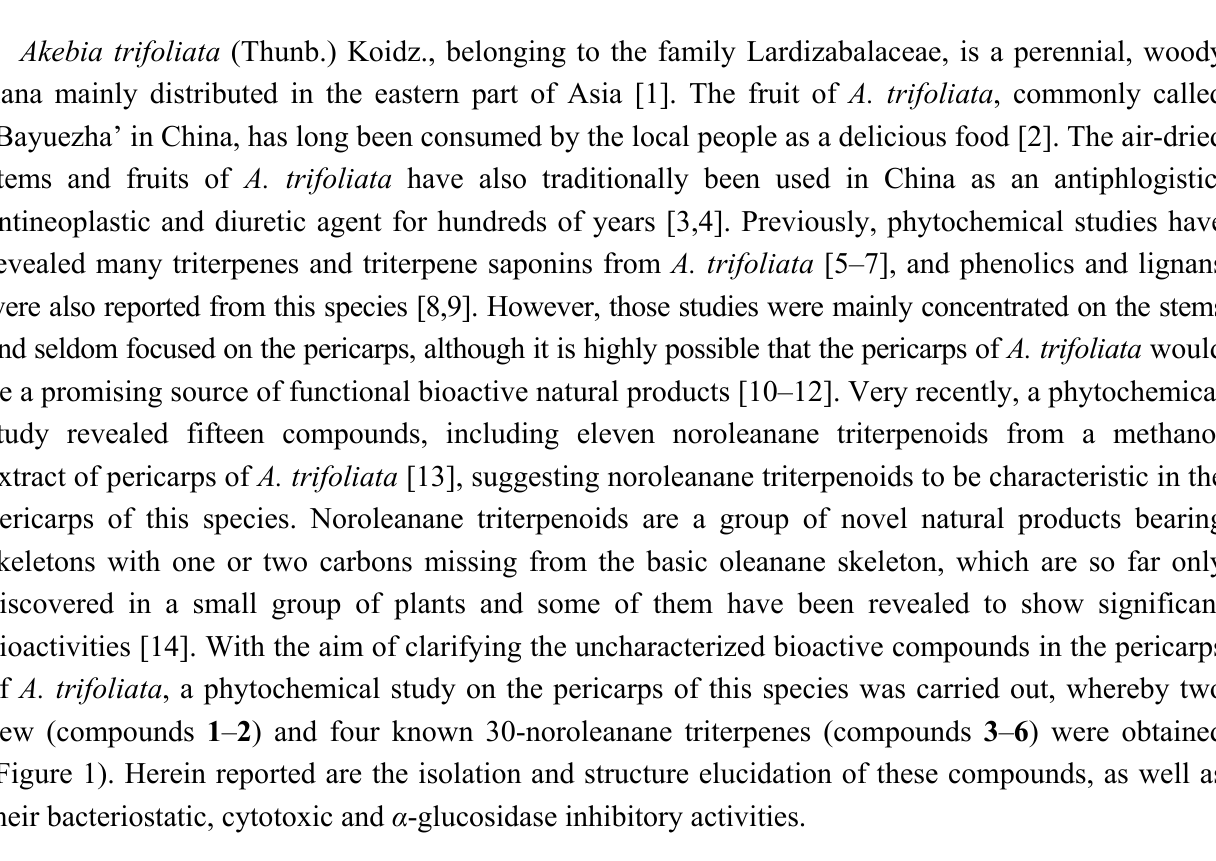
Figure 1. Chemical structures of compounds 1 − 6